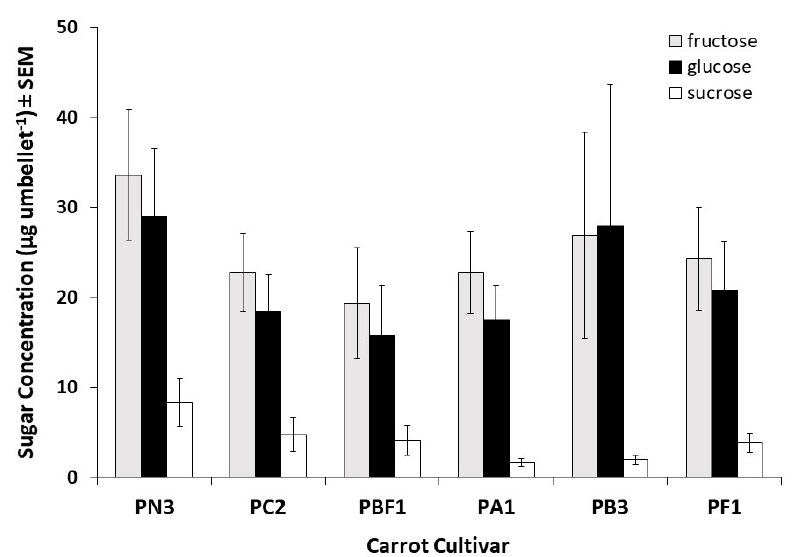
Figure 4. Fructose, glucose, and sucrose content (mean ± SEM) of nectar collected from six hybrid CMS carrot cultivars observed for insect visitation during trial B (n = 7 per cultivar).